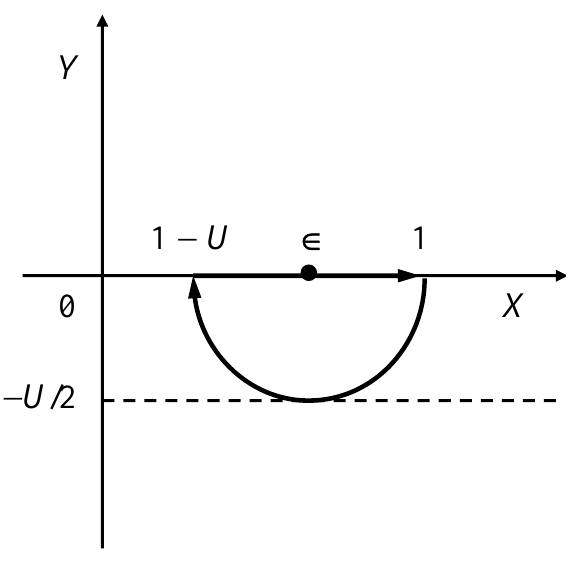
Fig. 1. A limit cycle in the state space of the spring-block system with constant driver